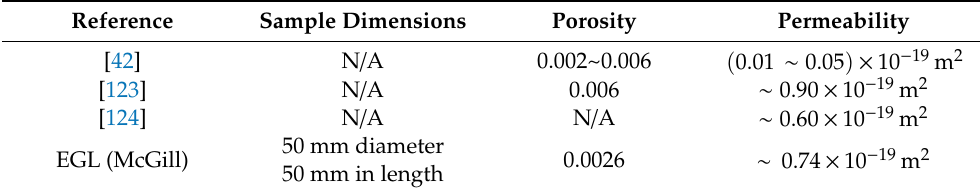
Table 6. Permeability estimates for the Lac du Bonnet